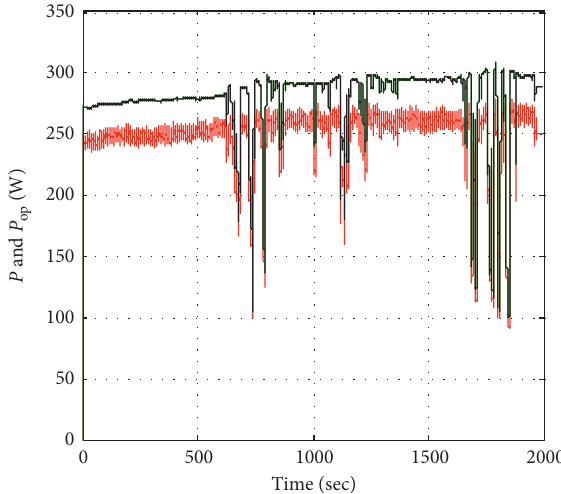
Figure 21: Evolution of real and reference powers of PVG.